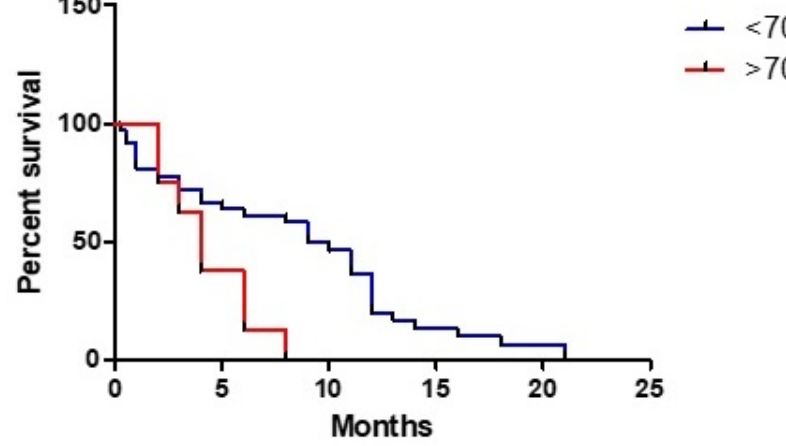
Figure 1. Prognostic role of age on overall survival. Figure 1 . Prognostic role of age on overall survival.